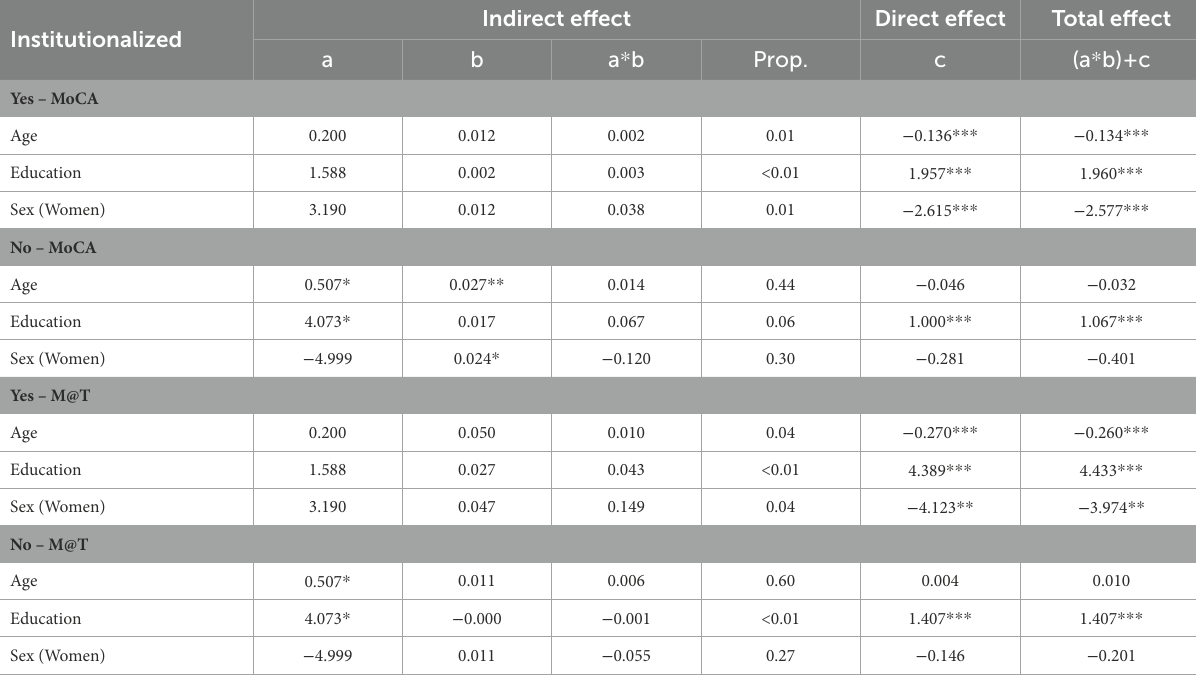
TABLE 4 Mediation analysis of sociodemographic predictors of cognitive performance (assessed with MoCA and M@T) contrasted with cognitive reserve as a mediating variable (assessed with PIL), separating the effects in the samples of institutionalized and non-institutionalized participants.